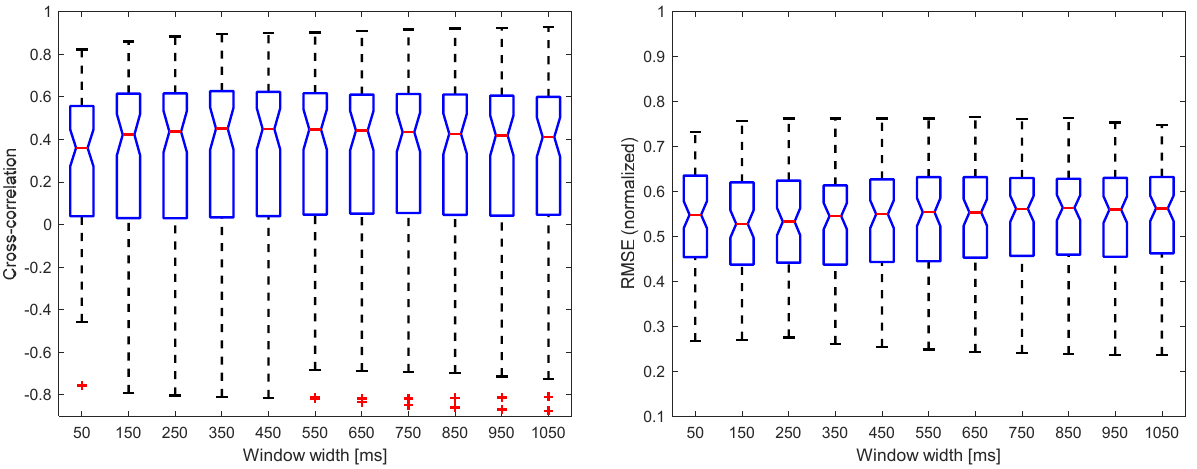
Sensors 2022 , 22 , x FOR PEER REVIEW